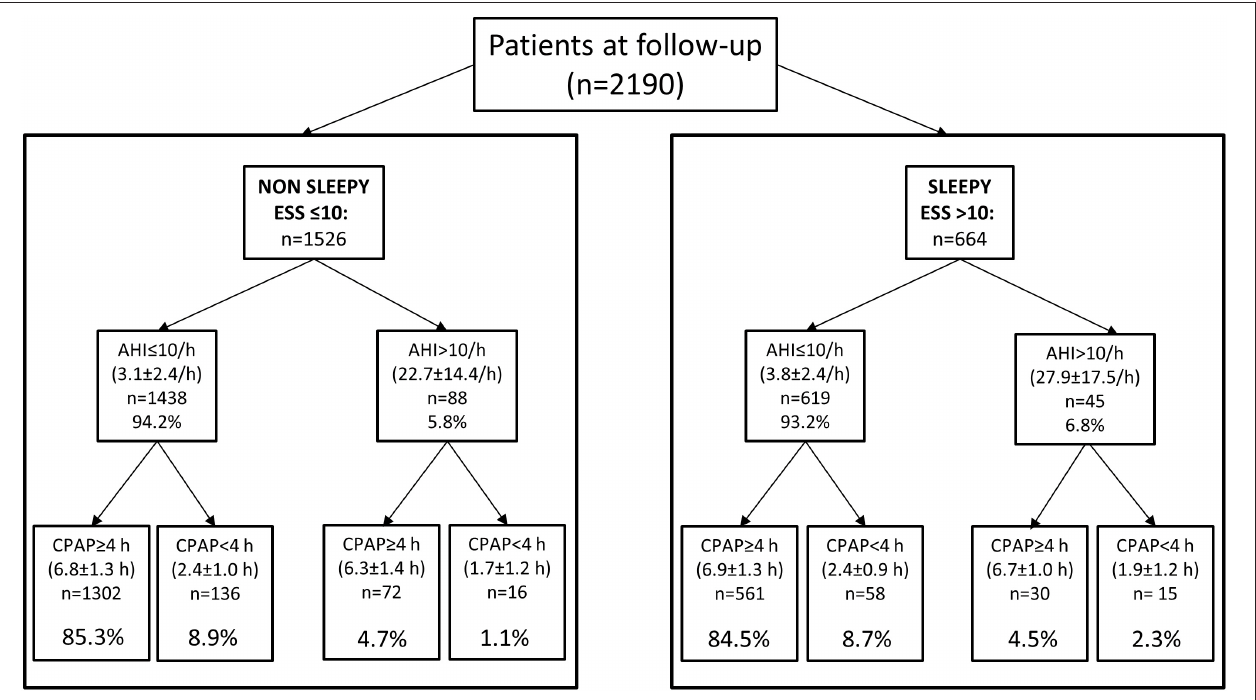
FIGURE 2 | Analysis of the sample (sleep monitoring data available in 2,190 patients) according to resolution of OSA and adherence to CPAP treatment in patients without and with EDS at follow-up. Mean ± SD for AHI and CPAP use are reported in each box. Percentage of patients with incomplete OSA resolution or poor CPAP adherence was similar in patients with and without persistent sleepiness at follow-up (percentages in lower boxes refer to the non-sleepy and sleepy samples,